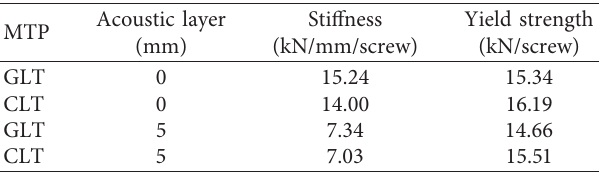
Table 2: Properties of the self-tapping screw.